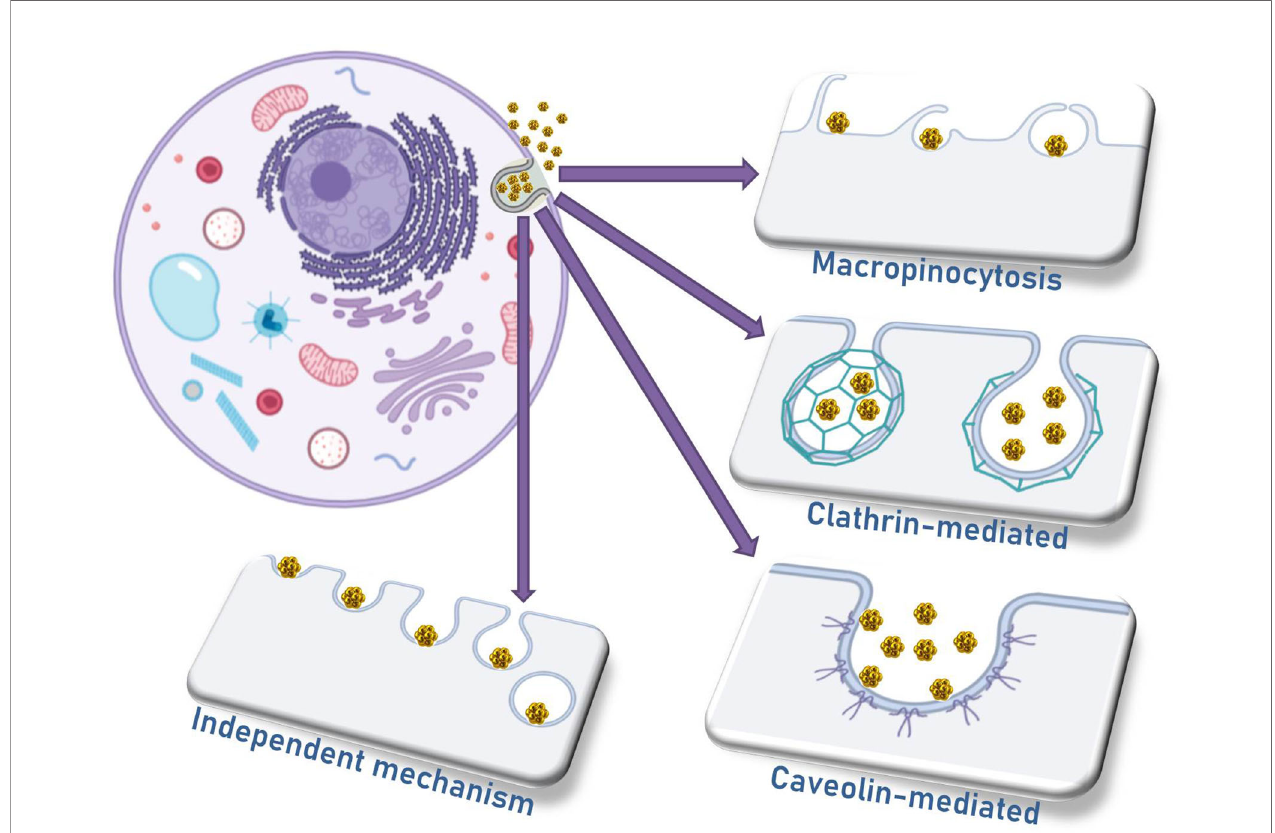
FIGURE 3 | The four main mechanisms responsible for the cell internalization of